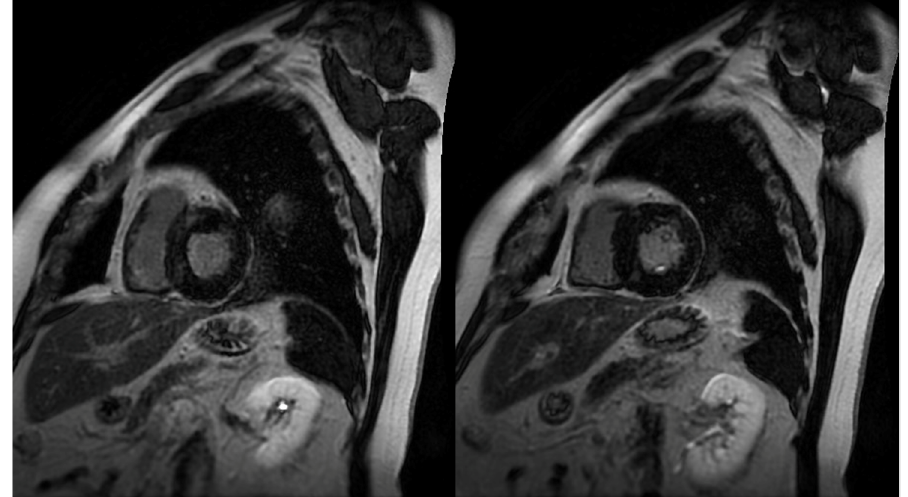
Figure 1. Short axis images demonstrating patchy late gadolinium enhancement (LGE) in hyper- trophic cardiomyopathy (HCM) patients. Common patterns identified in HCM patients include localization in segments with greatest left ventricular hypertrophy (LVH), and right ventricular (RV) insertion points.